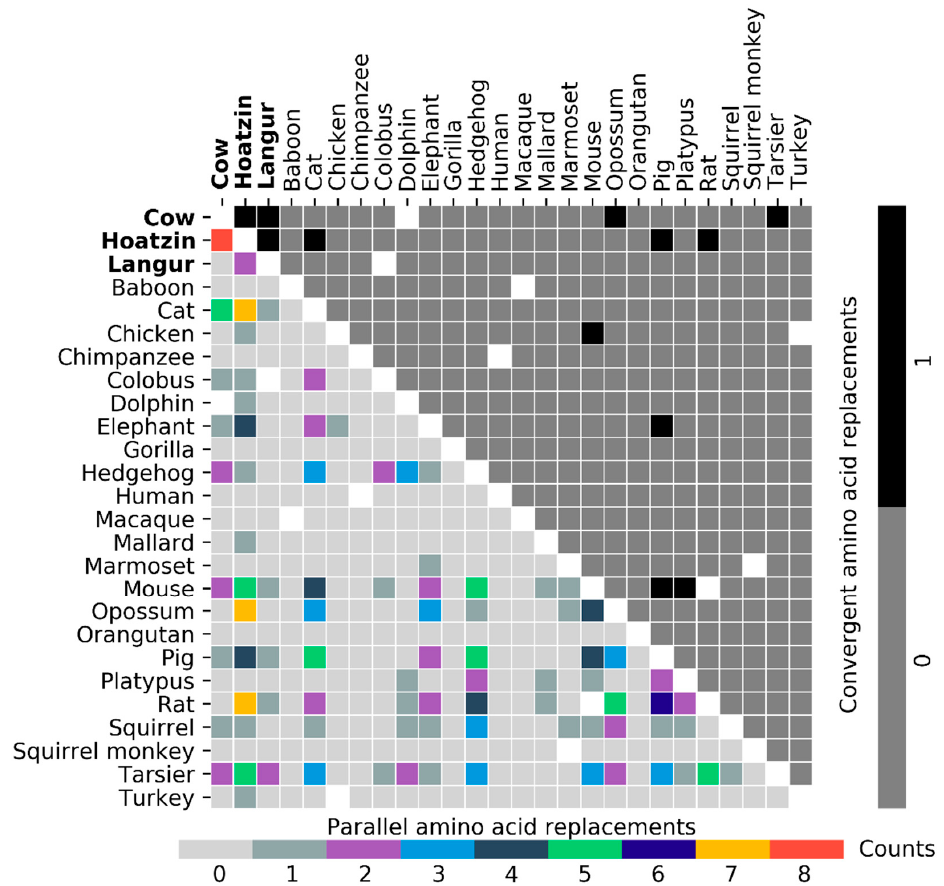
Figure 4. Observed numbers of parallel (lower triangle) and convergent (upper triangle) amino acid replacements for branch pairs involving only terminal branches. Off-diagonal empty squares indicate the branch pairs were excluded from the comparisons due to each of them involving two connected branches. Three foregut fermenters are shown in